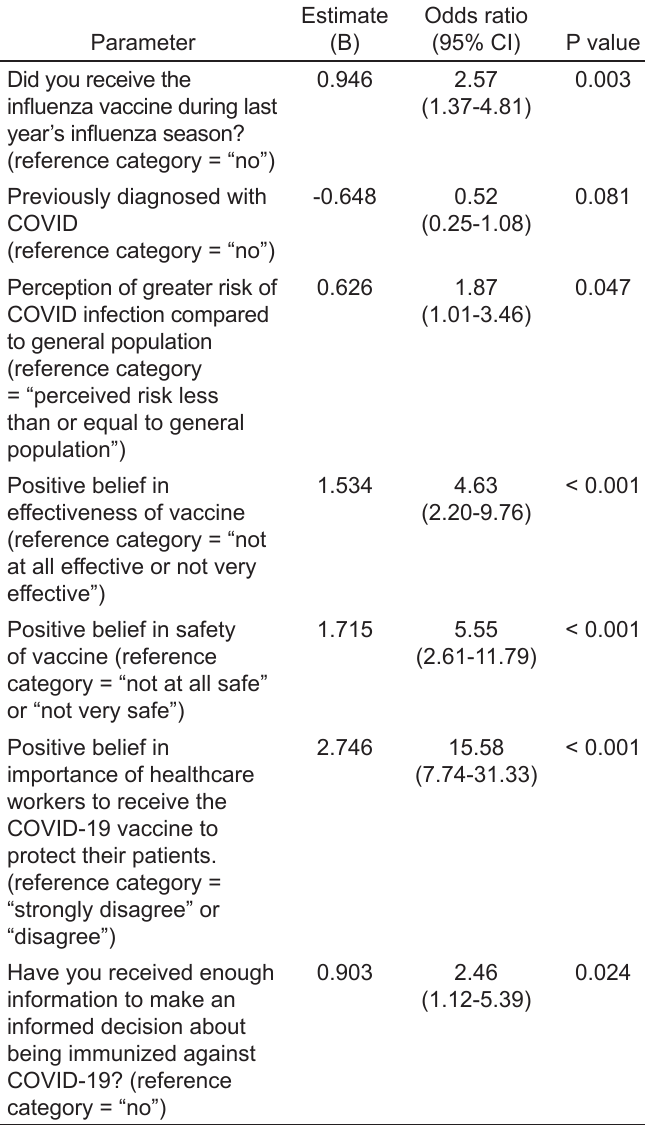
Table 5. Logistic regression model results for prediction of COVID-19